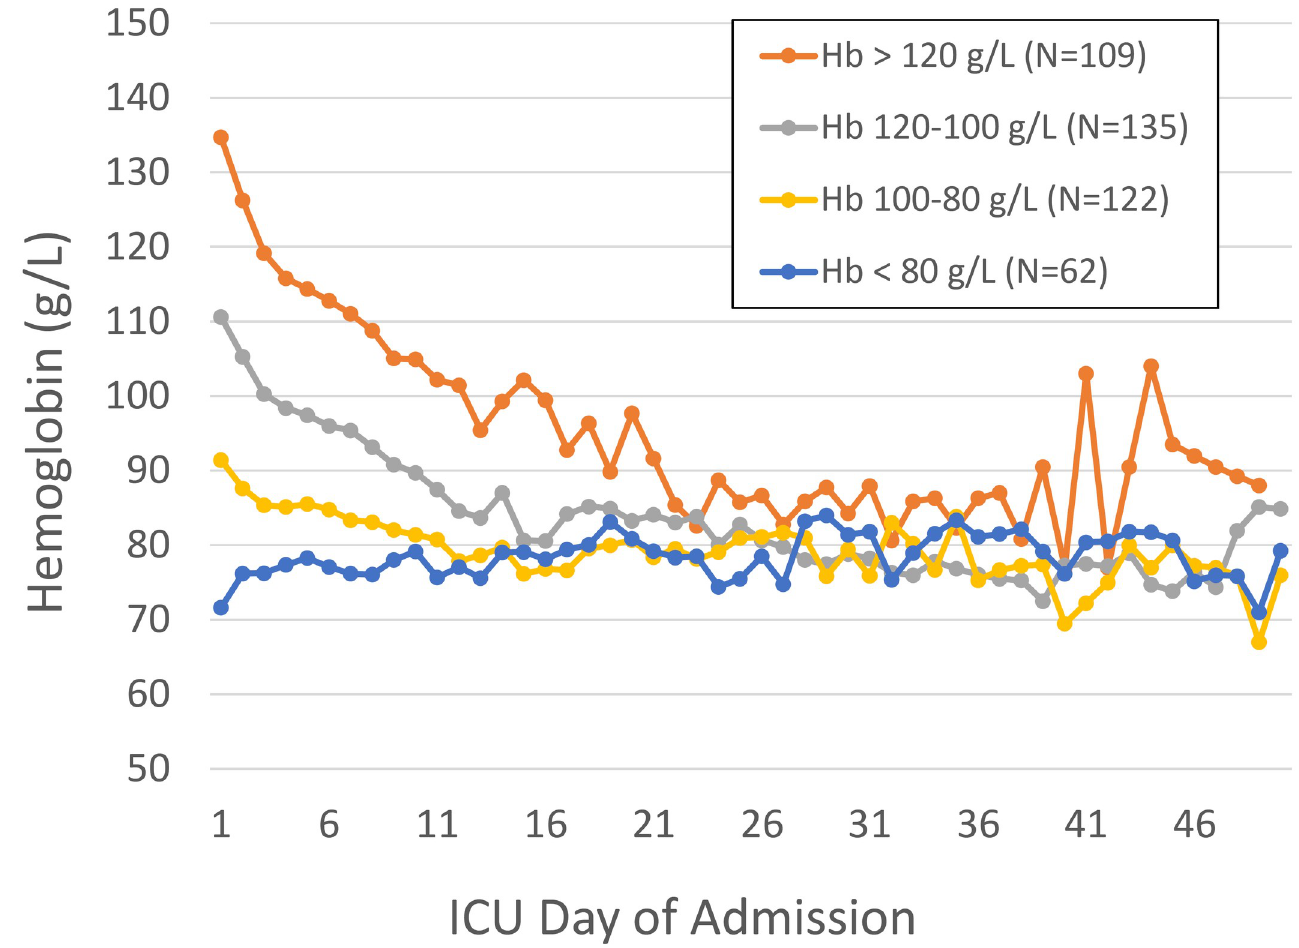
Fig 2. Hemoglobin trend by ICU day stratified by admission hemoglobin level. N = 428.